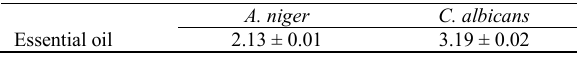
Table 5 . Antifungal property of nano emulsion of clove essential oil Table 5. Antifungal property of nano emulsion of clove essential